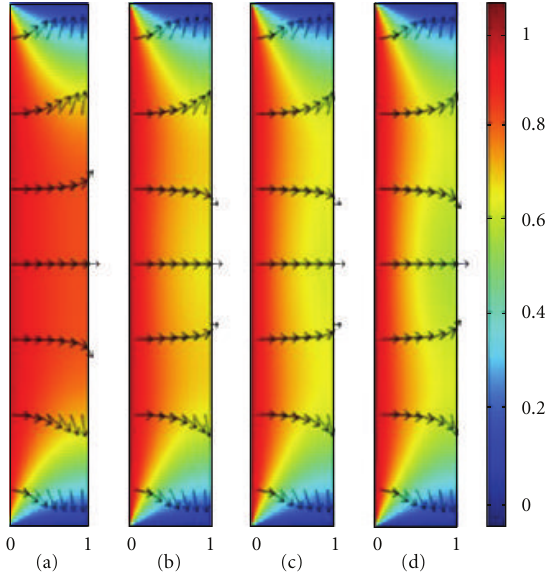
Figure 5: Distribution of dimensionless methanol concentration at T = 333 K, c 0 M = 1 . 0 M, E 0 = 0 . 4V, κ e = 3 . 4 Ω − 1 m − 1 , D e = 3 . 04 × 10 − 10 m 2 s − 1 ; (a) l = 10 μ m, a = 1 . 0 × 10 5 m − 1 ; (b) l = 25 μ m, a = 1 . 0 × 10 5 m − 1 ; (c) l = 50 μ m, a = 1 . 0 × 10 5 m − 1 ; (d) l = 25 μ m, a = 1 . 0 × 10 6 m − 1 ; arrow: the gradient of dimensionless methanol concentration.